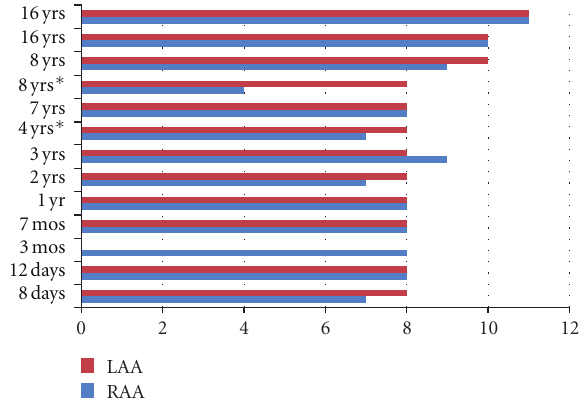
Figure 2: Time-to-first emigration. The time in days to first phase- bright cell emigration is displayed for a subgroup with right arterial appendage (RAA) and left atrial appendage (LAA) in a group of patients selected to span the pediatric age range of our patients (8 days to 16 years). All of the patients, except the two patients marked with an asterix, had end-stage heart failure at the time that the atrial appendages were